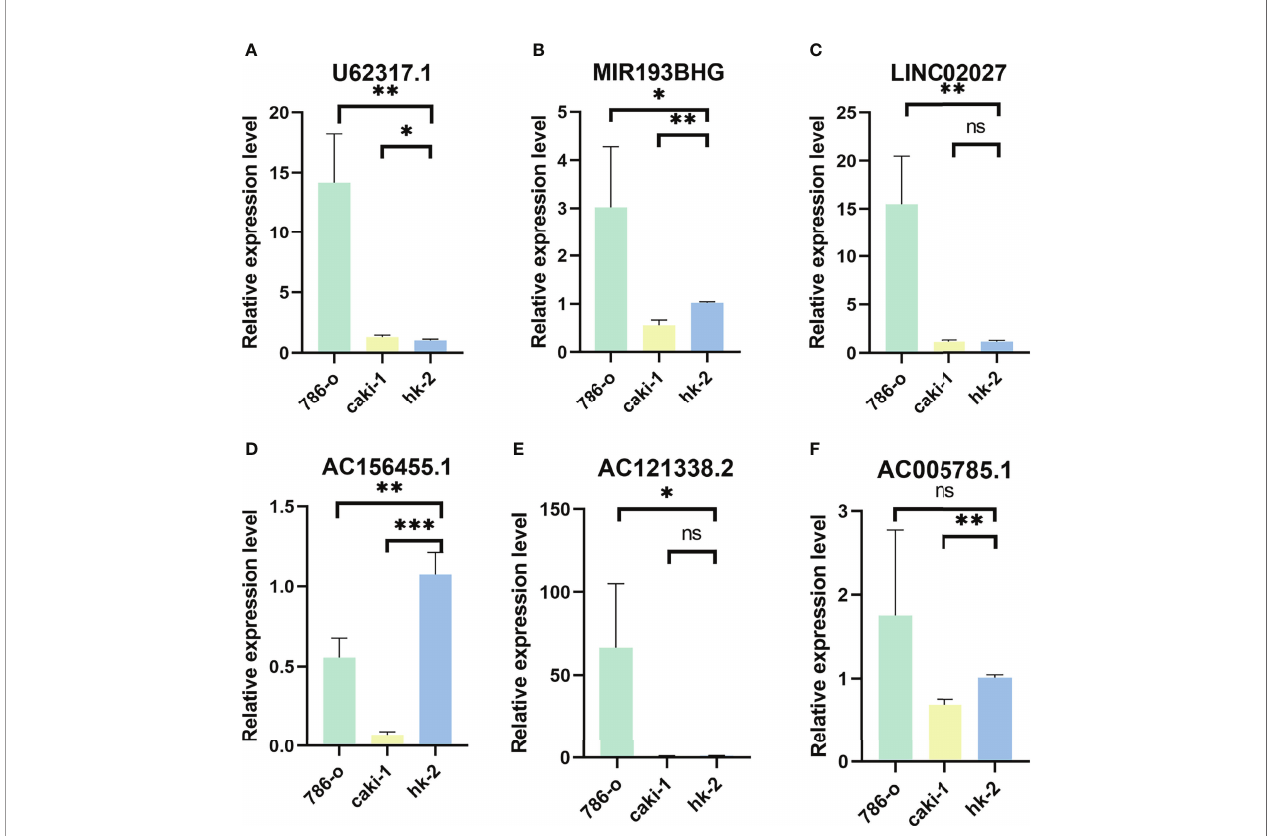
FIGURE 9 | Validation of results through quantitative PCR. Relative expression of 6 PRLs in three cell lines (786-O, Caki-1, HK-2): (A) U62317.1, (B) MIR193BHG, (C) LINC02027, (D) AC156455.1, (E) AC121338.2, and (F) AC005785.1 (* p < 0.0, ** p < 0.001, *** p <